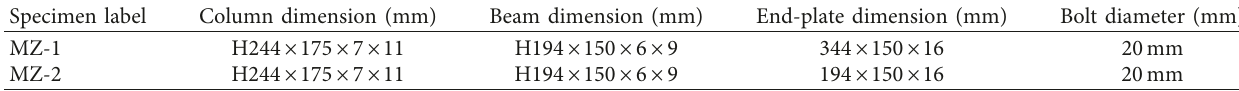
Table 1: Geometric properties of the specimens.